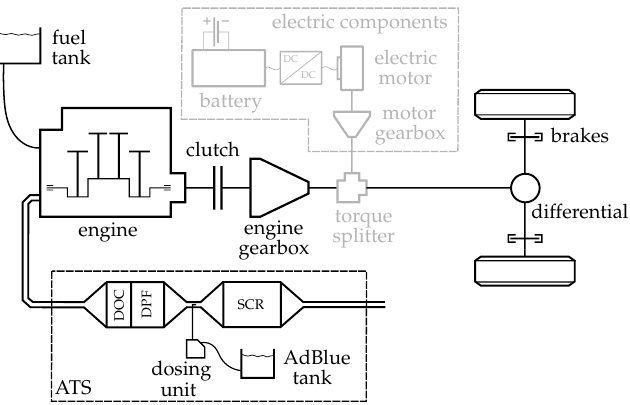
Figure 1. Vehicle powertrain layout. The components shown in gray are featured in the HEV, but not in the conventional